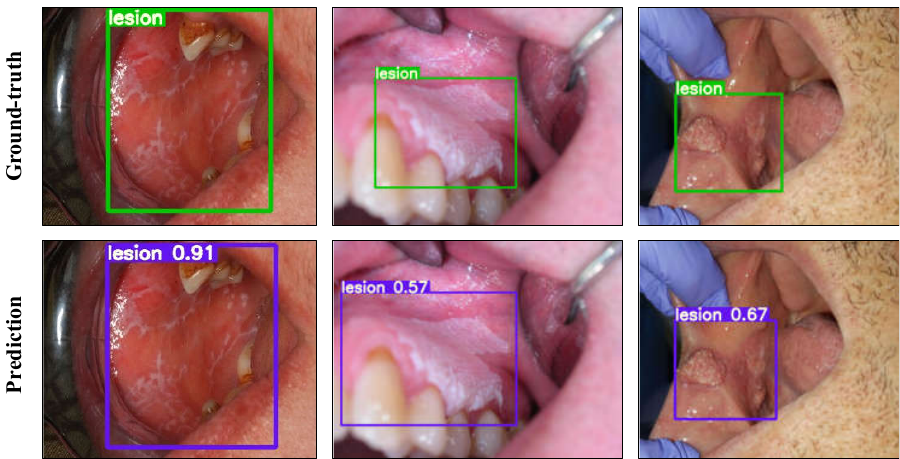
Figure 4. Lesion detection results with YOLOv5l on the test set. The top and bottom rows show the ground-truth boxes and the model predictions, respectively. The values printed on top of the predicted boxes are the confidence scores for each predicted box.